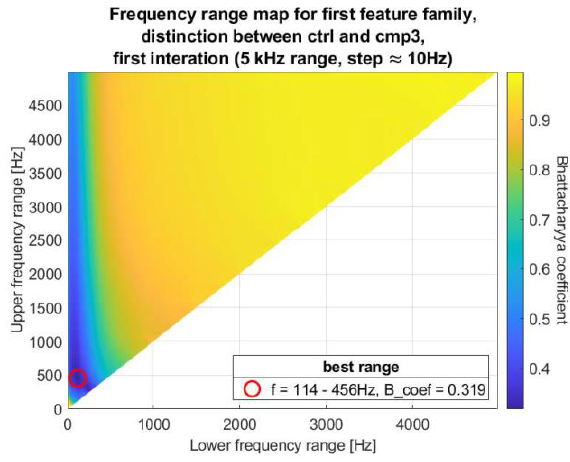
Figure 2. Example of the frequency range map (FRM).